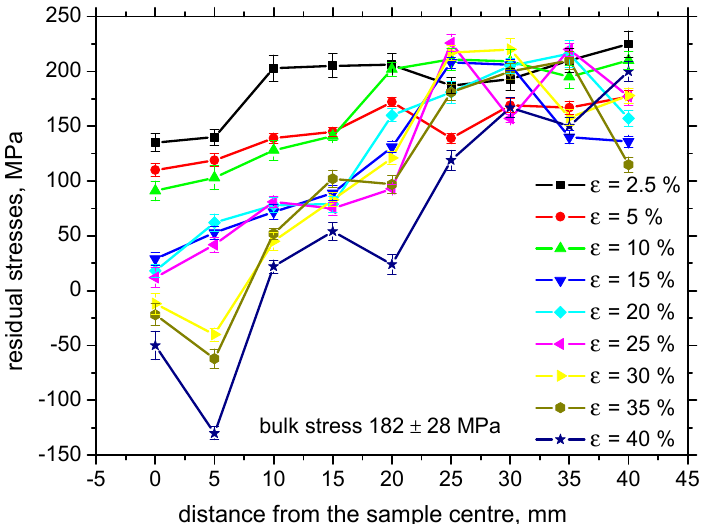
Figure 9. Evolution of residual stresses for the different ε , RD.